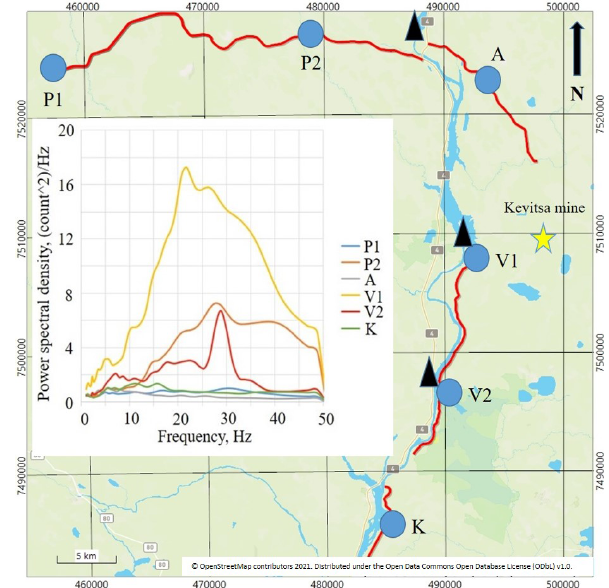
Figure 2. Illustration of noise level at six stations located in dif- ferent profiles of the XSoDEx experiment. The positions of strong noise sources (Kevitsa mine (yellow star) and dams of waterpower stations (black triangles)) and seismic stations selected for analysis (blue circles) are indicated. Brown and white lines show roads. The inset figure shows a comparison of ambient noise power spectral density estimated at selected